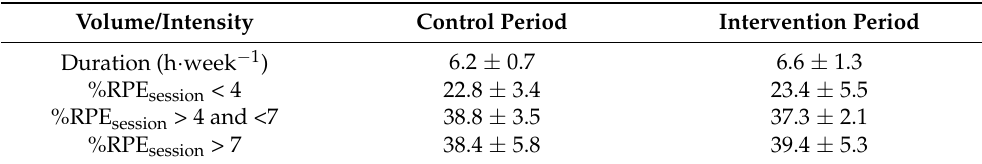
Figure 2. ( A ) maximal voluntary isometric contraction (MVIC) pre (white bars) versus post-intervention (black bars) of the right and left legs; ( B ) vastus lateralis cross-sectional area pre- (white bars) versus post-intervention (black bars) of the right and left legs. Table 2. Volume (duration) and intensity (RPE) of the habitual cycling training performed during the control period (four weeks) and the intervention period (nine